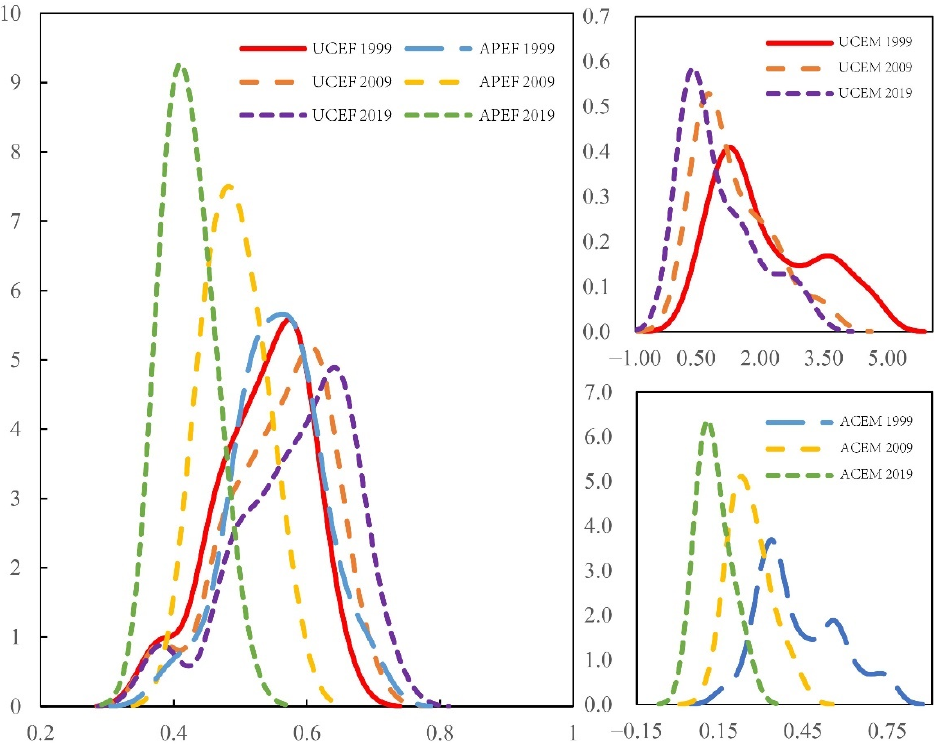
Figure 4. Kernel density curve of territorial space use efficiency and carbon emission intensity in 1999, 2009, and 2019; UCEF, APEF, UCEM, and ACEM are the urban construction efficiency, agricultural production efficiency, urban carbon emission intensity, and agricultural carbon emission intensity. The internal class step is 0.03, 0.4, and 0.04, respectively.